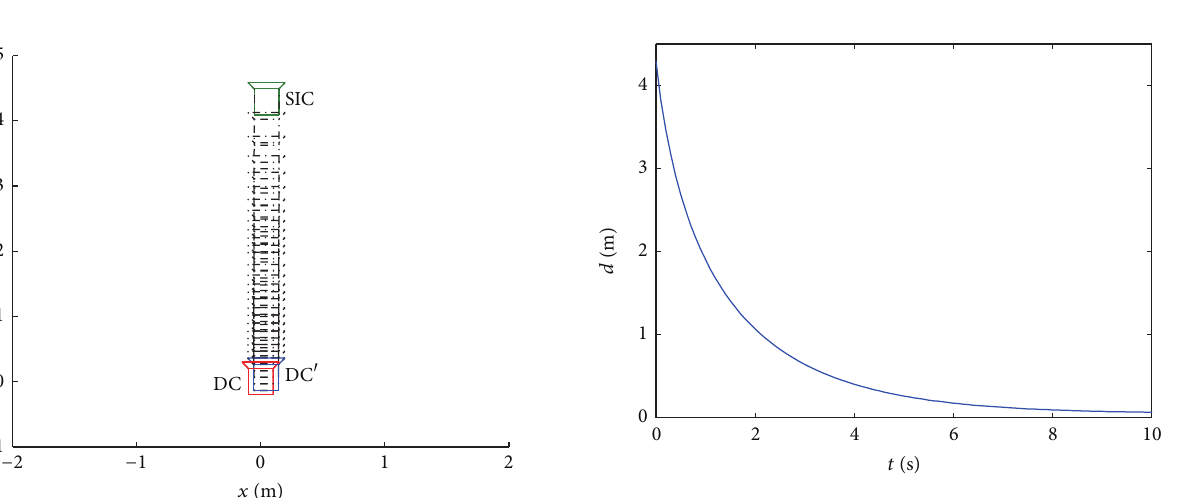
𝑢 1 and angular velocity of the robot